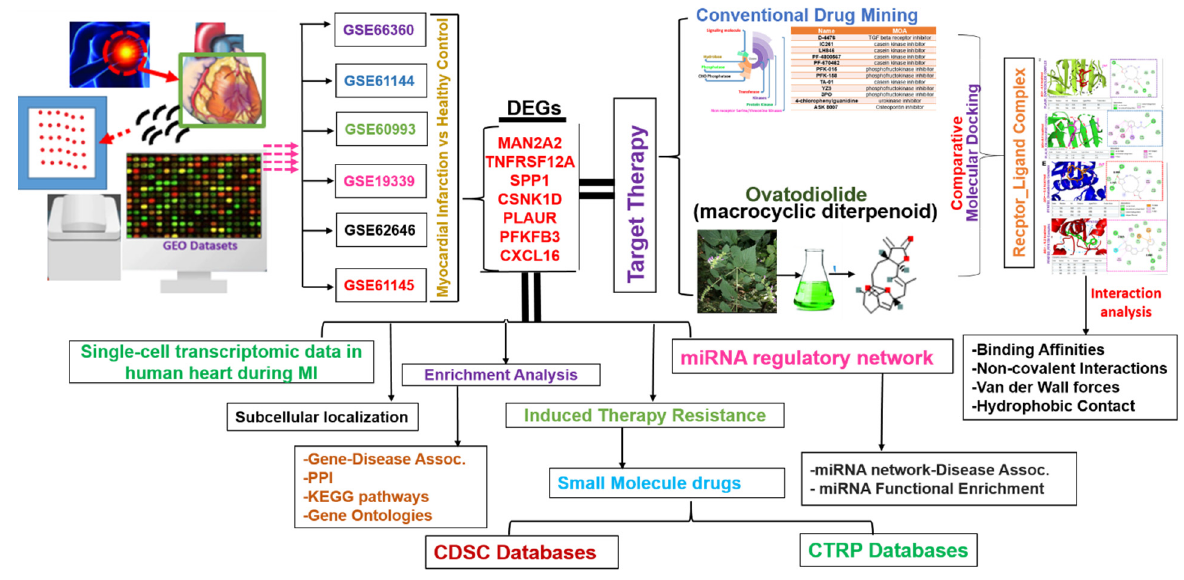
Figure 1. Schematic representation of the study workflow for the identification of the theranostic signature of metabolic and immune-inflammatory dysregulation with myocardial infarction and the potential therapeutic function of ovatodiolide, a macrocyclic diterpenoid.